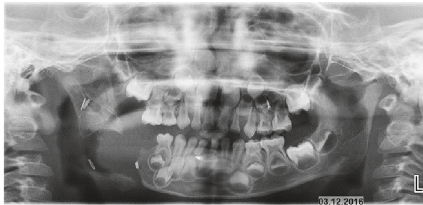
Figure 6: Postoperative OPG showing spontaneous regeneration of